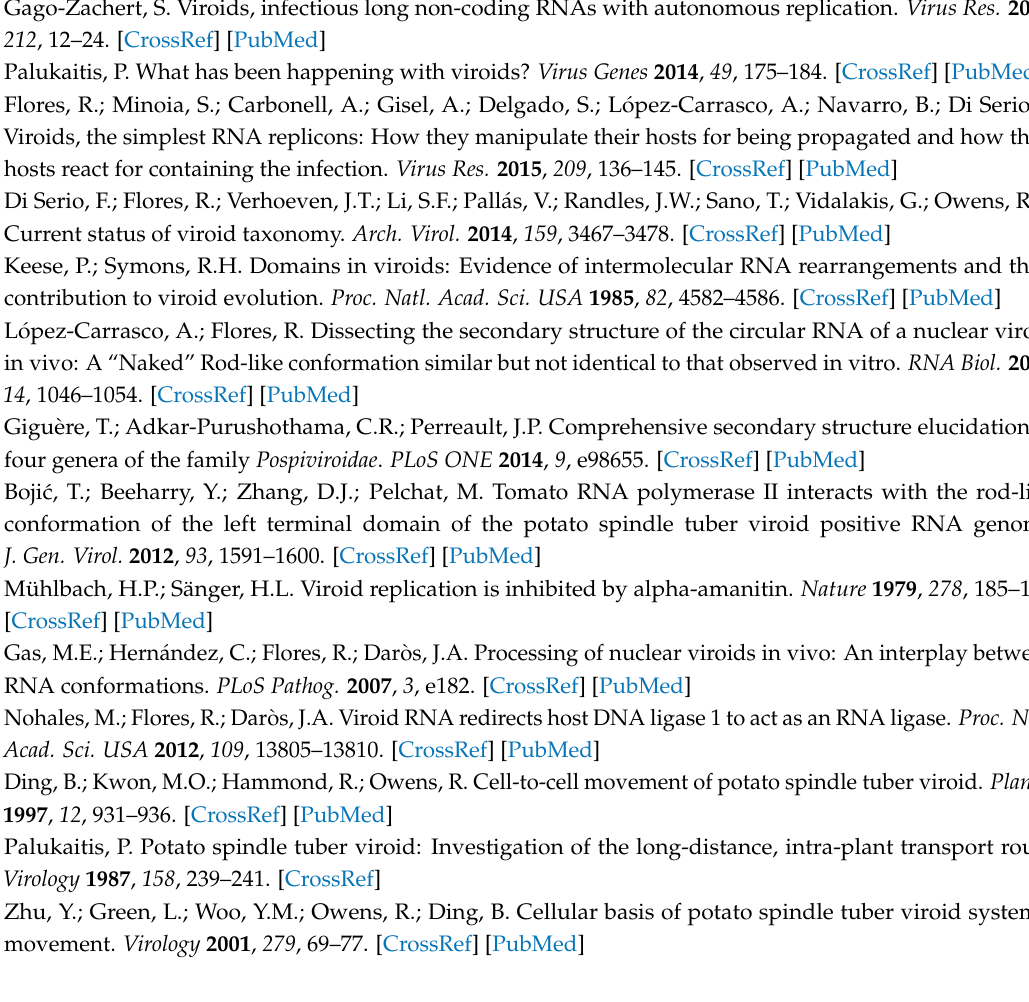
Figure S1: Gene Ontology (GO) terms assigned to the complete list of the differentially expressed genes, Table S1: NanoString nCounter analysis of the selected DEGs, Table S2: Tomato DEGs affected by PSTVd-M and PSTVd-S23 infection, Table S3: GO term enrichments of different categories, Table S4: TF and PK genes in which expression was altered by PSTVd infection at particular time points, Table S5: Genes involved in plant hormone biosynthesis and signaling in which expression was altered by PSTVd infection, Table S6: Photosynthesis- and chloroplast-related genes in which expression was altered by PSTVd infection, Table S7: Differentially regulated cell-wall-related genes during PSTVd infection, Table S8. Differentially regulated defense-related genes during PSTVd infection. Author Contributions: A.G.-S. and W.Z.-O. conceived and designed the experiments; A.W., R.I.-N. and A.G.-S. performed the experiments; A.W., A.F. and A.G.-S. analyzed the data; A.G.-S. and A.W. wrote the